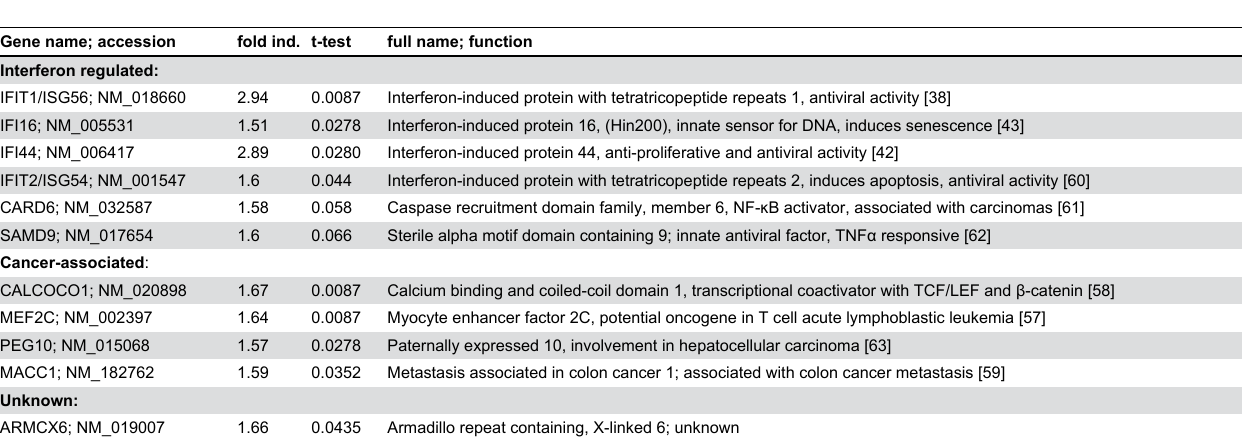
Table 2. ZNF395-induced genes, identified by microarray, are involved in the innate immune response and cancer